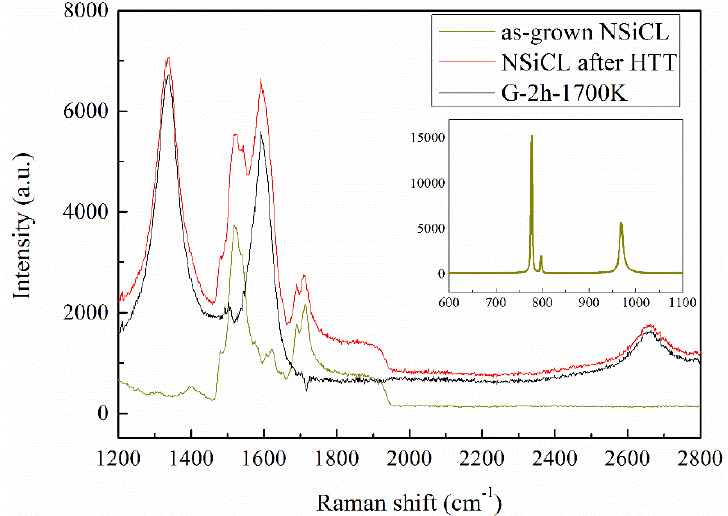
Figure 3. Raman spectra of the as-grown NSiCL and the NSiCL after a high temperature treatment (HTT), respectively, and the derived graphene of sample G-2h-1700K. Inset: Raman peaks of TO mode and LO mode of the as-grown